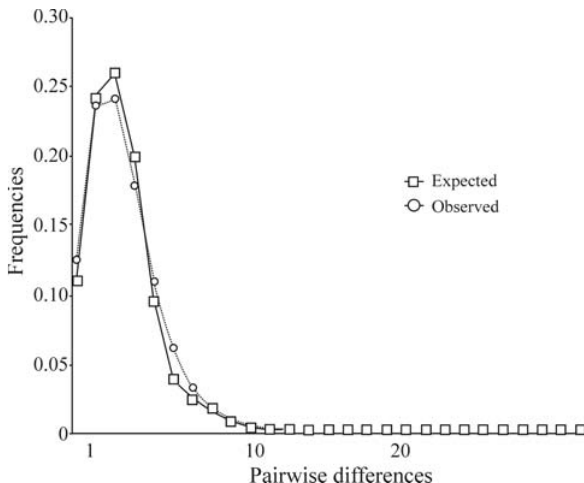
Figure 2 - Mismatch distribution for D-loop haplotypes in Cynoscion acoupa from the northern coast of Brazil. The expected frequency is based on a population growth-decline model (initial theta = 0.96, final theta = 1000, tau = 1.427), determined using the DNASP v4.20.2 program (Rozas et al. ,